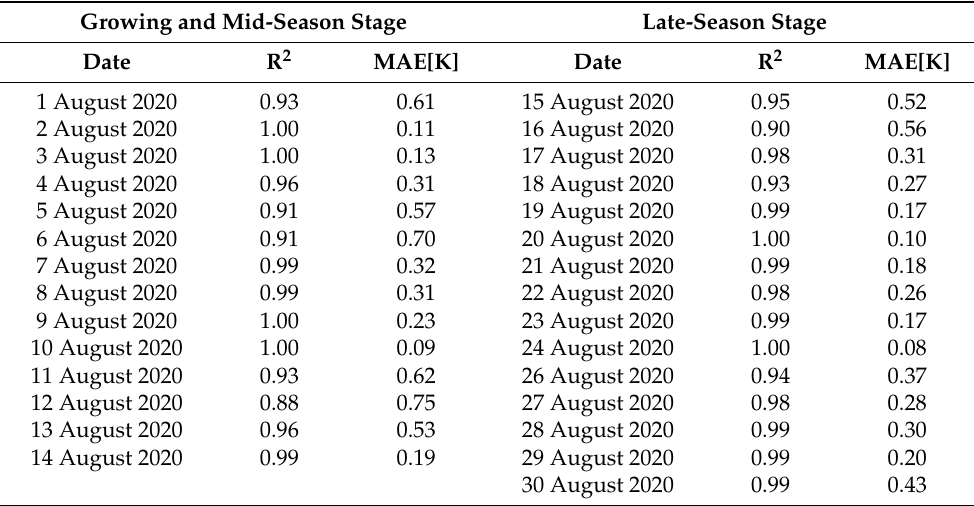
Table 2. The performance indicators of R 2 and MAE in evaluating the model predictions of the temperature above the canopy of an irrigated soybean crop during the middle and late-season stages. Growing and Mid-Season